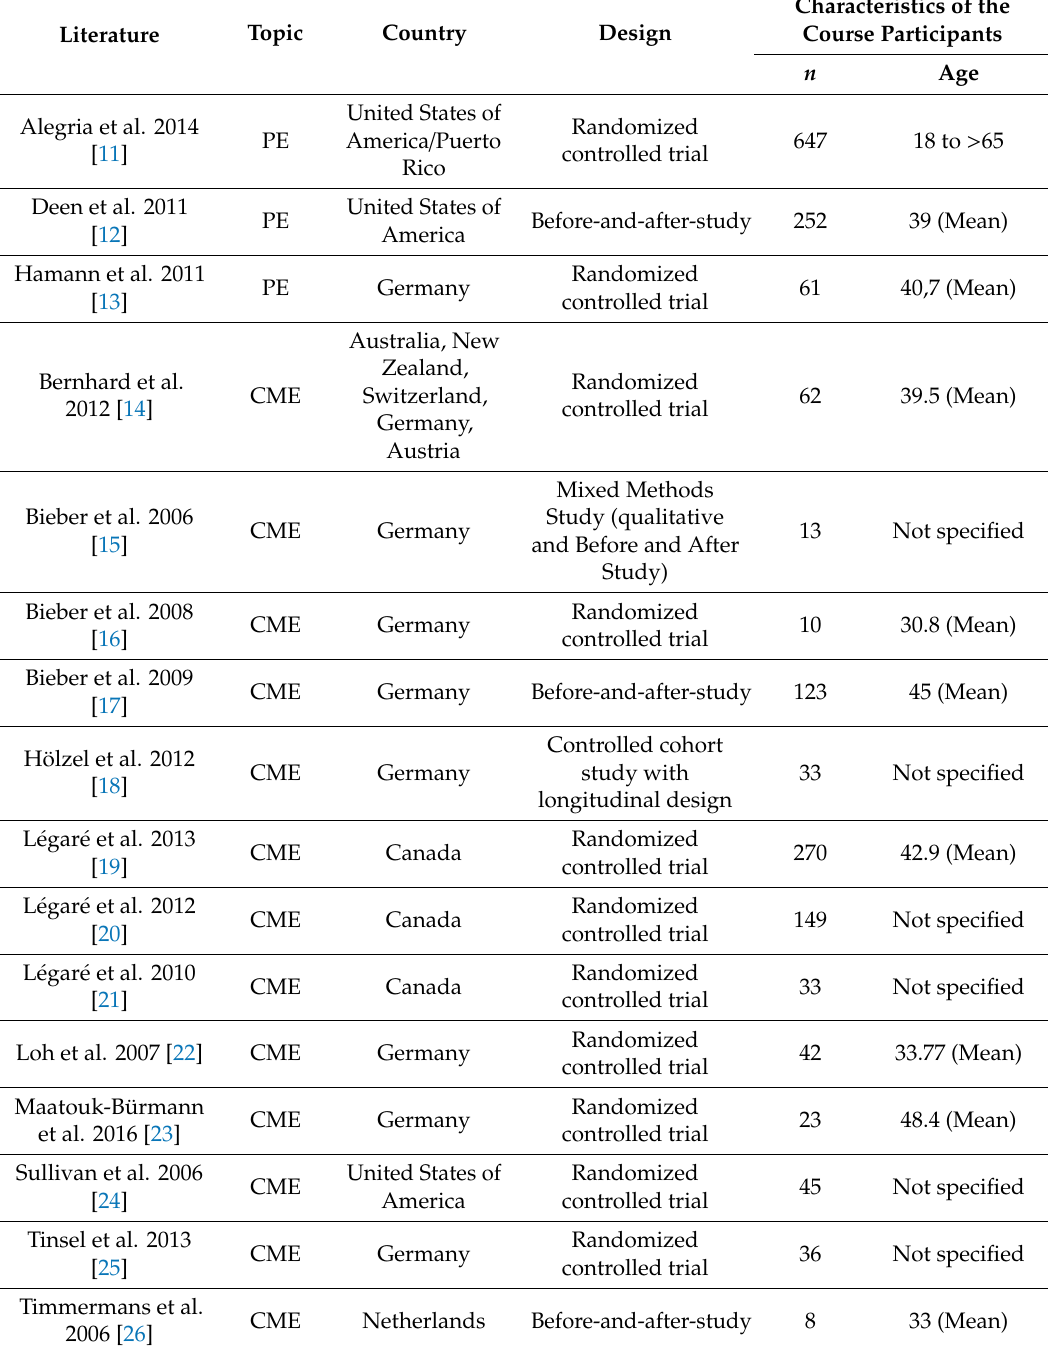
Table 1. Study overview—Patient education and continuing medical